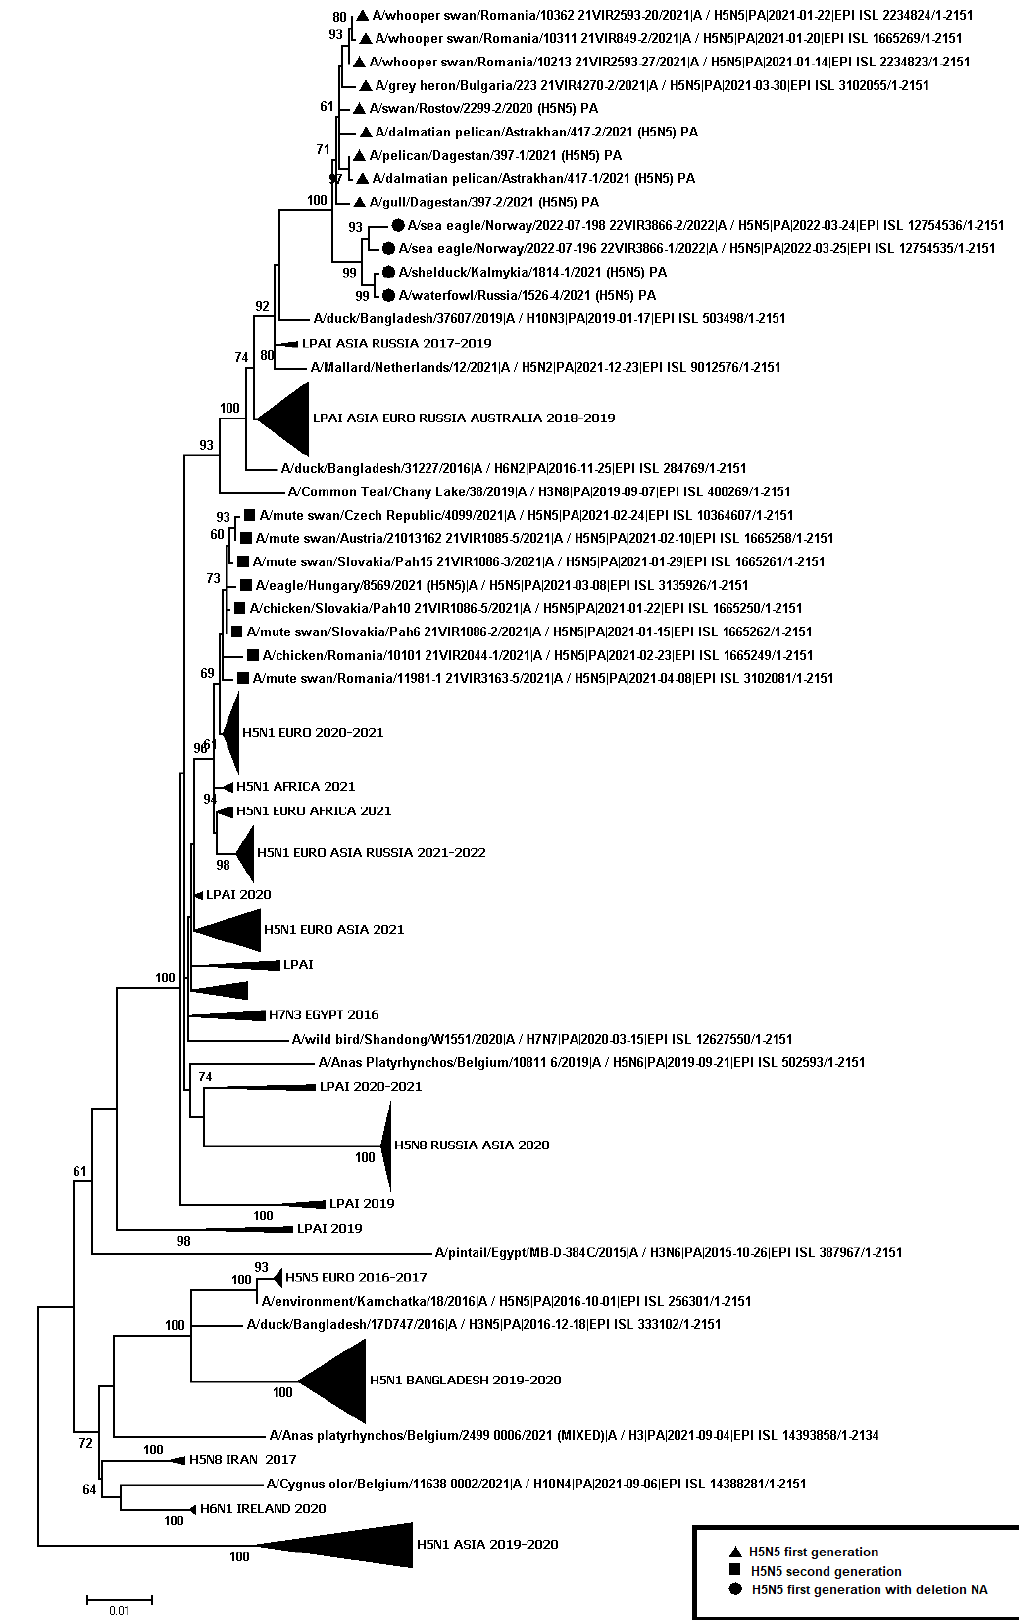
Figure 6. Phylogenetic tree constructed using the NJ method, based on the nucleotide sequence of the Р A gene fragment (1–2151 bp ORF) of AIV subtype H5.